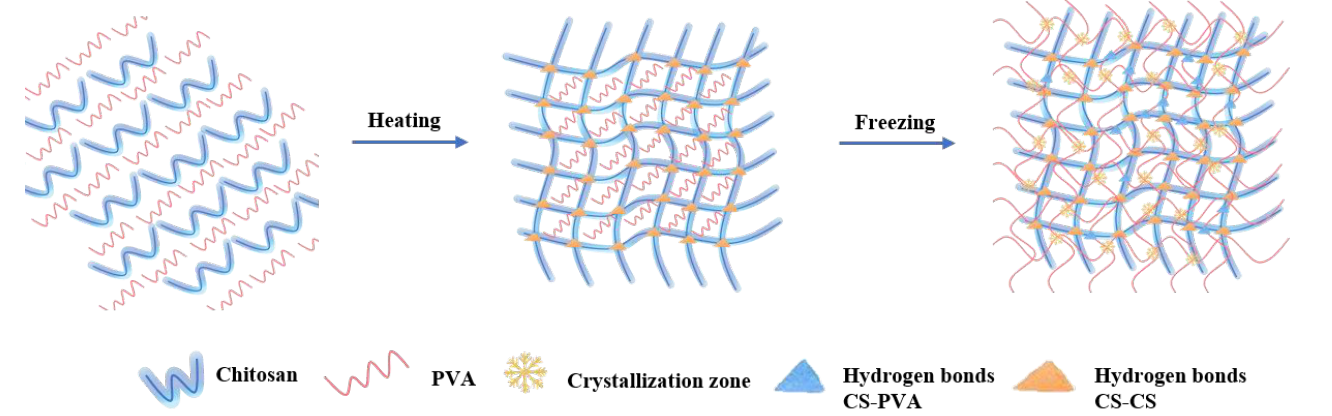
Figure 1. The scheme of preparing the CS/PVA hydrogel.